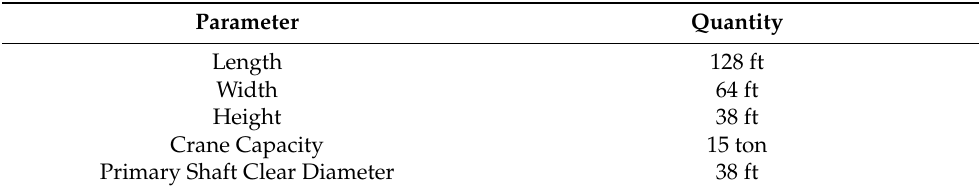
Figure 179. The Near Detector facility includes a steel-frame building located above ground and on top of the primary shaft. The front façade incorporates transparent cladding which provides a well-lit highbay for equipment staging. Table 27. Surface building